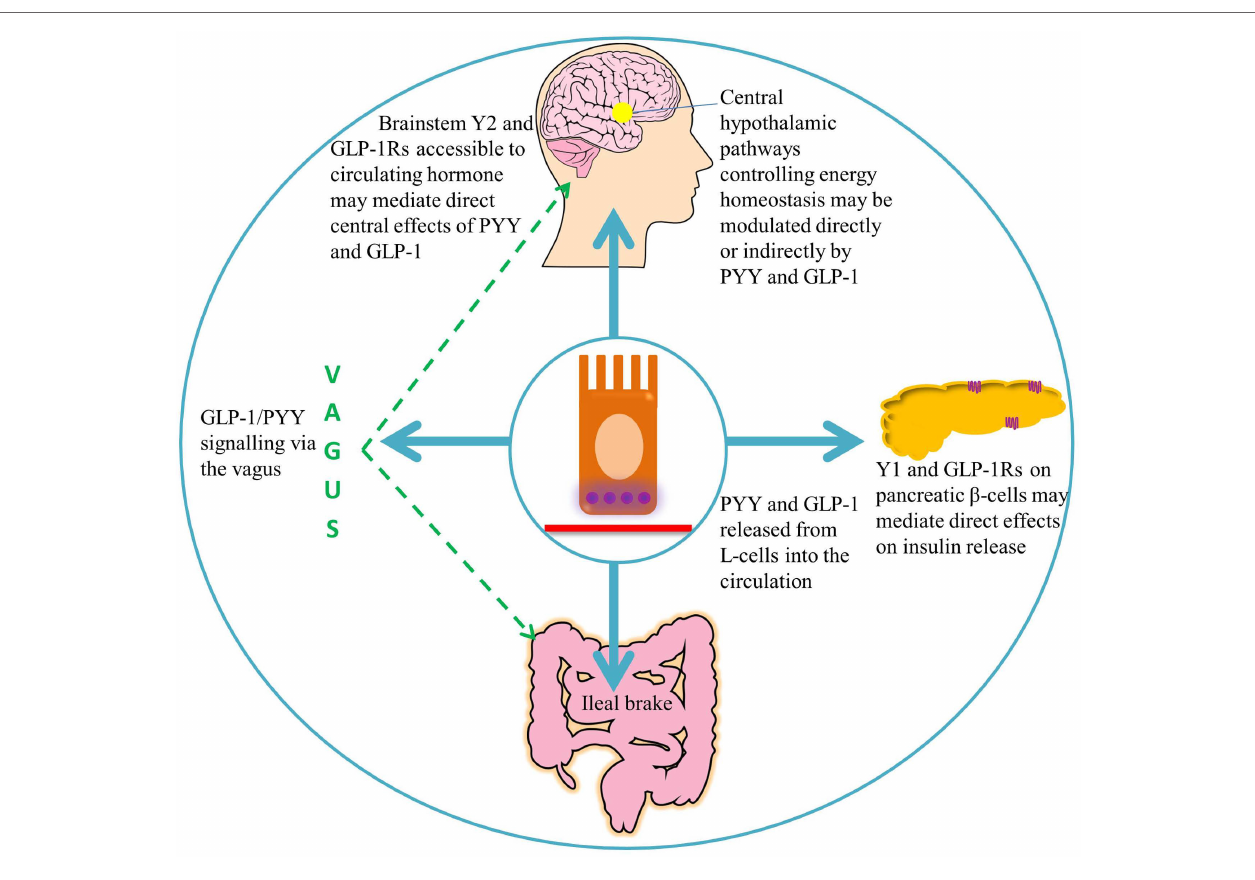
receptors (56, 57). Circulating hormones are able to access areas of the hindbrain with a leaky blood–brain barrier, such as the area postrema, which communicates with the nucleus of the solitary tract (58). GLP-1 and PYY 3–36 may signal via the vagus to central hypothalamic nuclei controlling energy homeostasis, where receptors for these hormones are widely expressed (46,